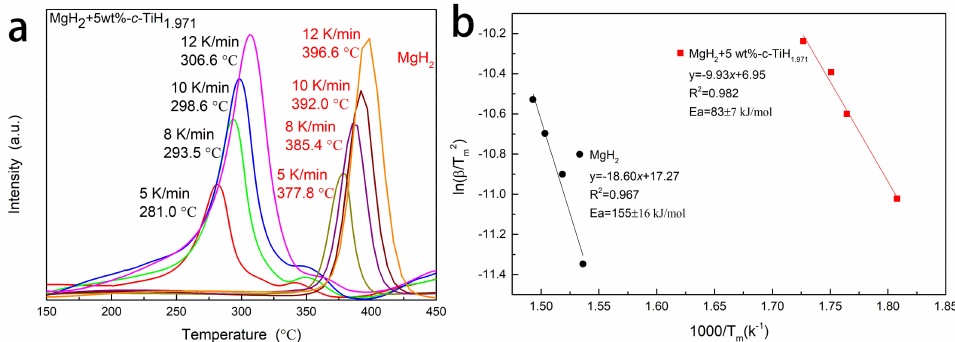
Figure 5. DSC curves of ( a ) prepared MgH 2 and MgH 2 + 5 wt%- c -TiH 1.971 at various heating rates (5, 8, 10, and 12 ◦ C / min) and estimations of the apparent active energies using the Kissinger method with the parameters obtained from DSC measurements ( b